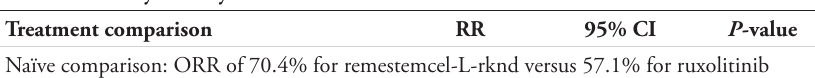
Table 2. Efficacy: 28-day ORR for Remestemcel-L-rknd Versus Ruxolitinib Treatment